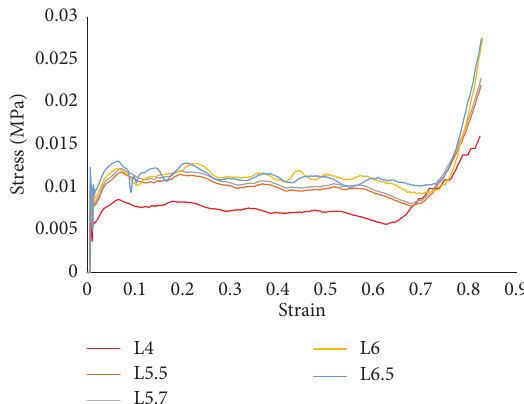
Figure 7: Stress-strain curves of honeycomb aluminum with different cell side lengths.